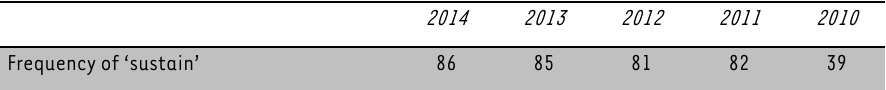
TABLE 10: Pick n Pay sustainability frequencies from 2010 to